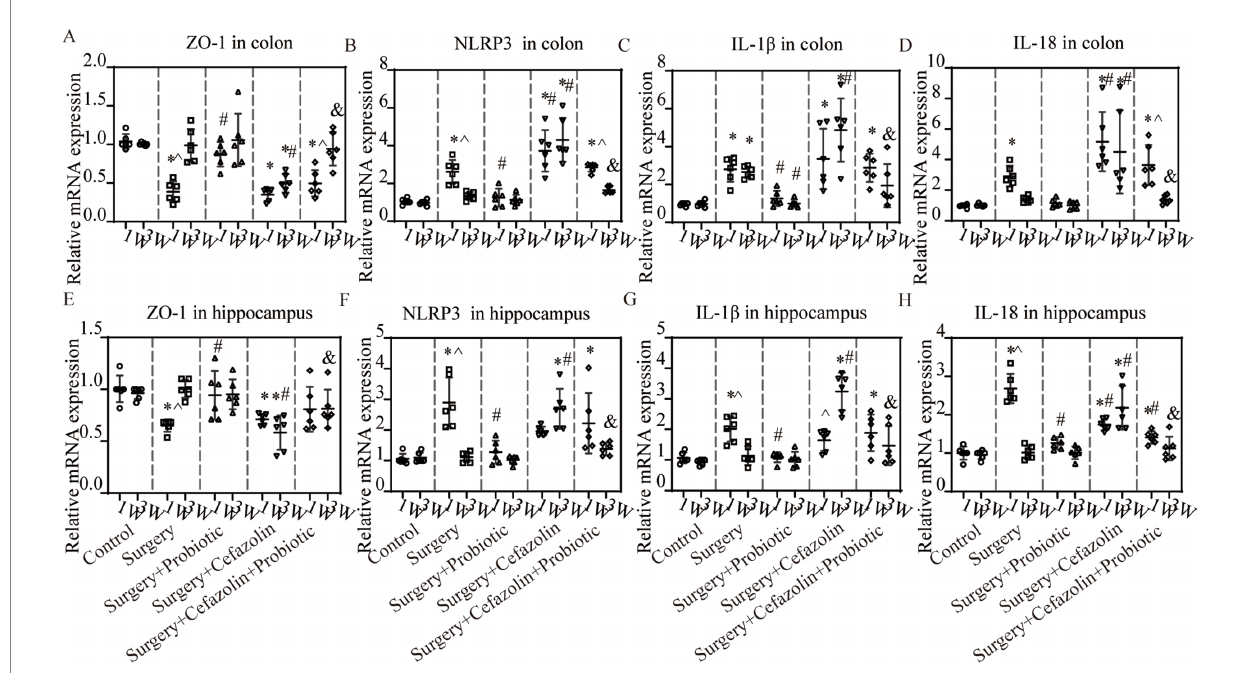
FIGURE 8 The probiotics administration for surgery/anesthesia stress-induced and perioperative cefazolin-induced inflammatory response and barrier permeability, respectively. (A,E) PCR: Surgery/anesthesia stress decreased the level of ZO-1 in the colon (q = 11.99, p < 0.0001) and hippocampus (q = 5.474, p = 0.0057) at 1 week, while probiotics could recover these decreases (ZO-1 in the hippocampus, q = 4.521, p = 0.0281; ZO-1 in the colon, q = 8.955, p < 0.0001); at 3 weeks after surgery, surgery + cefazolin group showed a decreasing level of ZO-1 in the colon (q = 5.874, p = 0.0028) and hippocampus (q = 7.139, p = 0.0003), while probiotics could increase these decreases of ZO-1 in the colon (q = 5.156, p = 0.0098) and hippocampus (q = 7.391, p = 0.0002; n = 6, ANOVA with Tukey’s multiple comparisons test). (B–D) PCR: Surgery/anesthesia stress increased the level of NLRP3 (q = 6.262, p = 0.0014), IL-1 β (q = 5.299, p = 0.0077), IL-18 (q = 4.343, p = 0.0372) in the colon at 1 week, while probiotics could recover some decreases (NLRP3, q = 5.434, p = 0.0061; IL-1 β , q = 4.389, p = 0.0346); at 3 weeks after surgery, surgery + cefazolin group showed an increasing level of NLRP3 (q = 14.83, p < 0.0001), IL-1 β (q = 10.37, p < 0.0001), IL-18 (q = 6.934, p = 0.0004) in the colon, while probiotics could decrease these increases